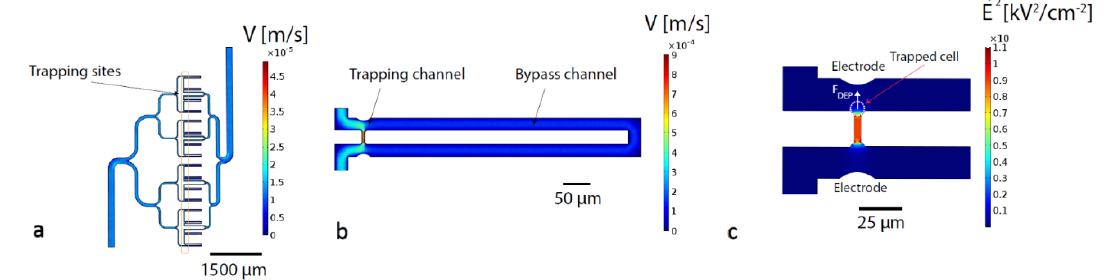
Figure 2. Simulations of the device layout and working principle. ( a ) Finite element simulation of the fluid velocity in the microfluidic channel (Inlet pressure: 0.1 mbar). ( b ) Finite element simulation of the fluid velocity in the microfluidic channel used to determine the ideal length of the channel ensuring the trapping of a single cell (Inlet pressure: 0.1 mbar). ( c ) Finite element simulation of the electric field in the channel. The field gradient is higher in the trapping region of the cell, generating a negative dielectrophoretic (DEP) force sufficient for the release of the cell from the trap (voltage difference between electrodes: 10 V).